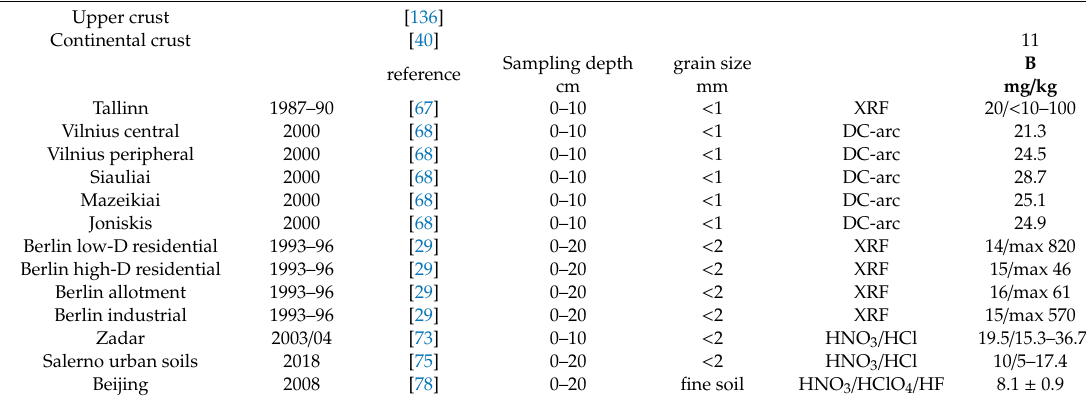
Table A4. Boron in urban soils.